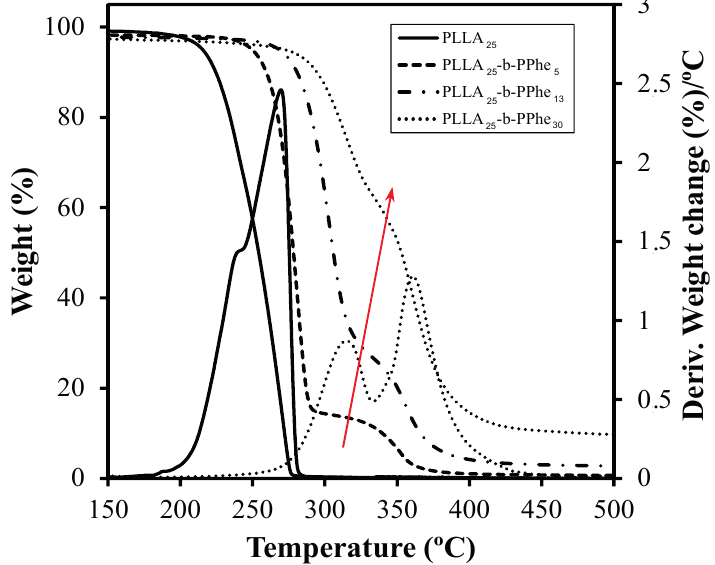
Figure 10. Thermogravimetric and representative derivative thermogravimetric curves of PLLA -NH and copolymers having different PPhe block 25 2